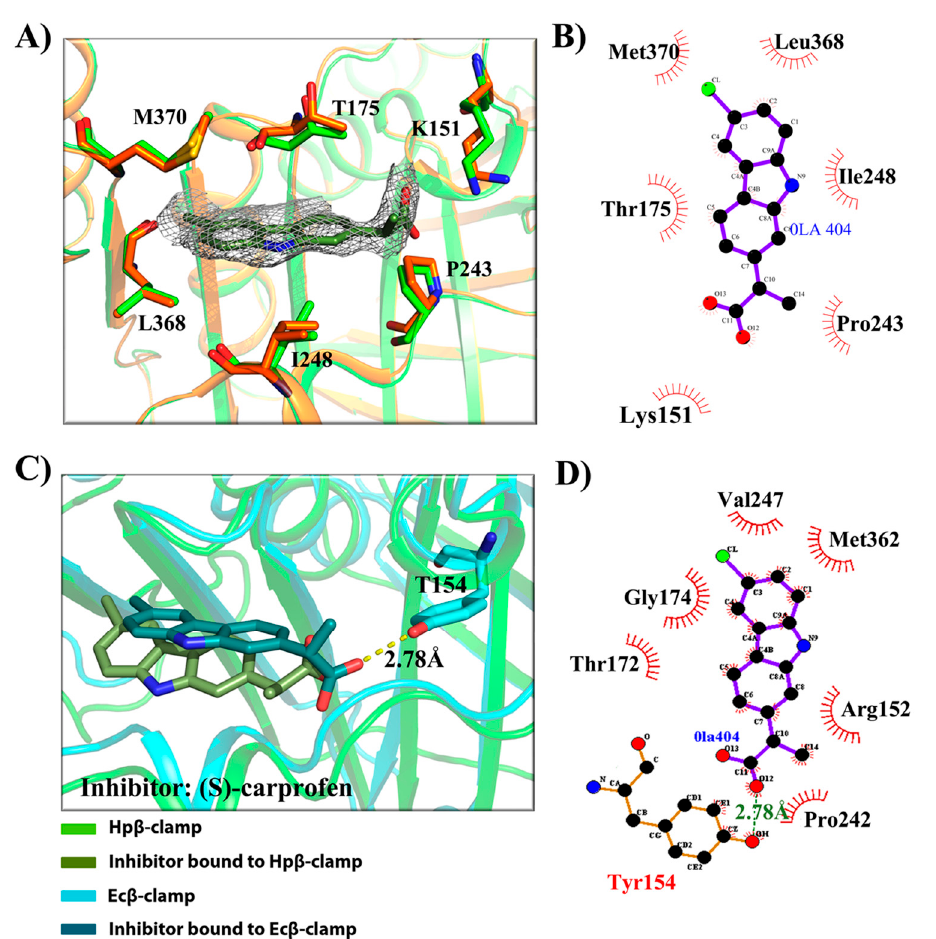
Figure 3. (S)-carprofen interaction with β -clamp. ( A ) 2Fo-Fc map, contoured at 1 σ , of (S)-carprofen bound to Hp β -clamp (PDB ID: 5FXT). The alignment of the structure of the co-crystal of Hp β -clamp (green) and the inhibitor (olive) with that of the native Hp β -clamp (orange) showed almost same orientation of interacting molecules in both structures; ( B ) Ligplot of the Hp β -clamp structure near the bound (S)-carprofen, showing the hydrophobic interactions between the protein and the inhibitor; ( C ) Structural alignment of H. pylori (green) and E. coli β -clamp (cyan) complex with ligand (S)-carprofen. T154 of Ec β -clamp makes H-bond with the ligand apart from other hydrophobic interactions while Hp β -clamp and ligand interactions are dominated by hydrophobic interactions; and, ( D ) Ligplot of Ec β -clamp with bound ligand showing its various interactions with ligand (PDB ID: 4MJR).